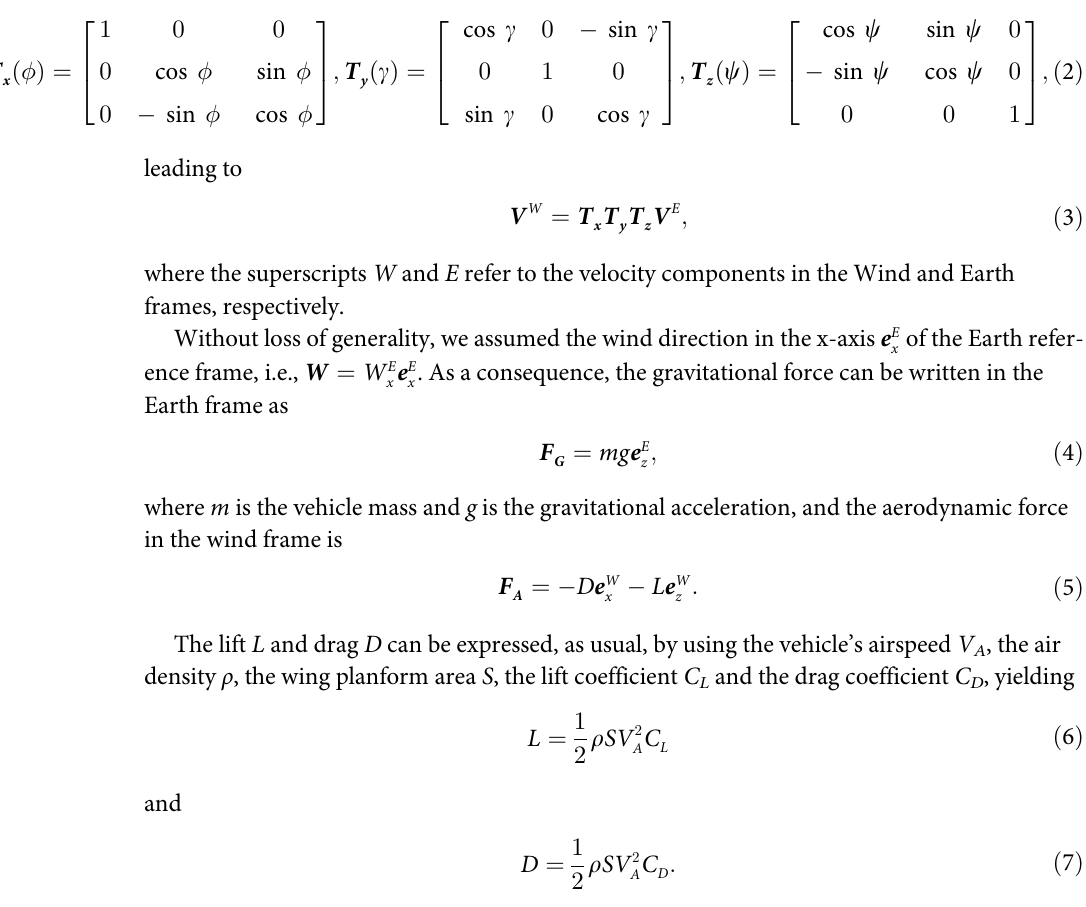
Fig 2. Relation between frames. Sketch of the three rotations T and Earth frames (E).